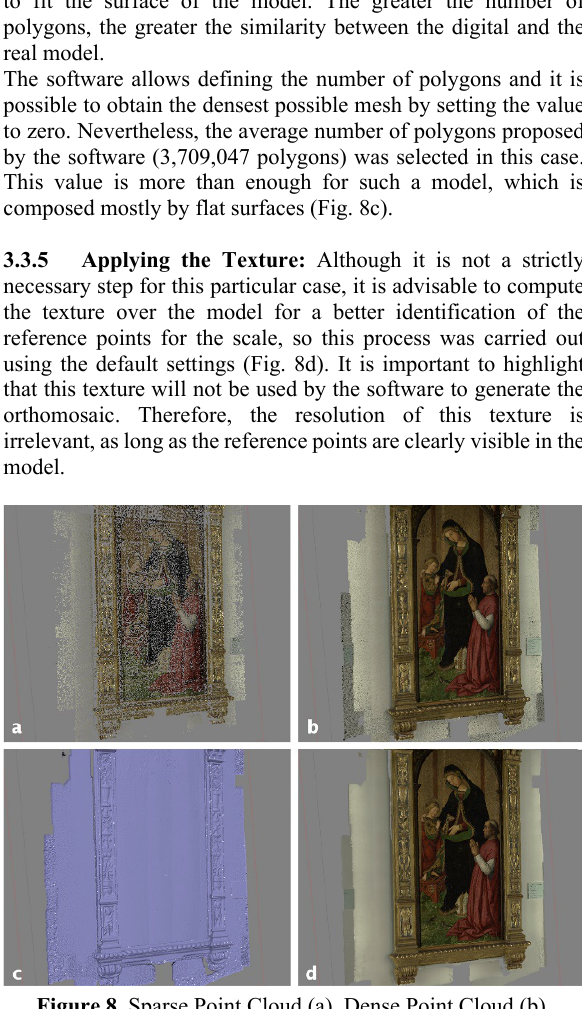
Figure 8 . Sparse Point Cloud (a). Dense Point Cloud (b). Polygonal Mesh (c). Textured Model